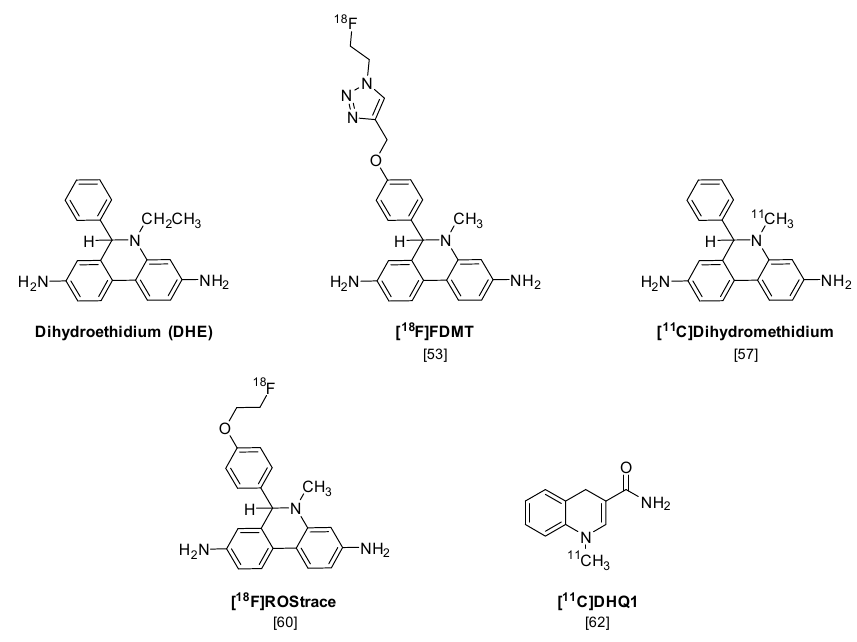
Figure 5. Structures of the positron emission tomography (PET) radiotracers for imaging increased levels of reactive oxygen species (ROS) in neuroinflammation.